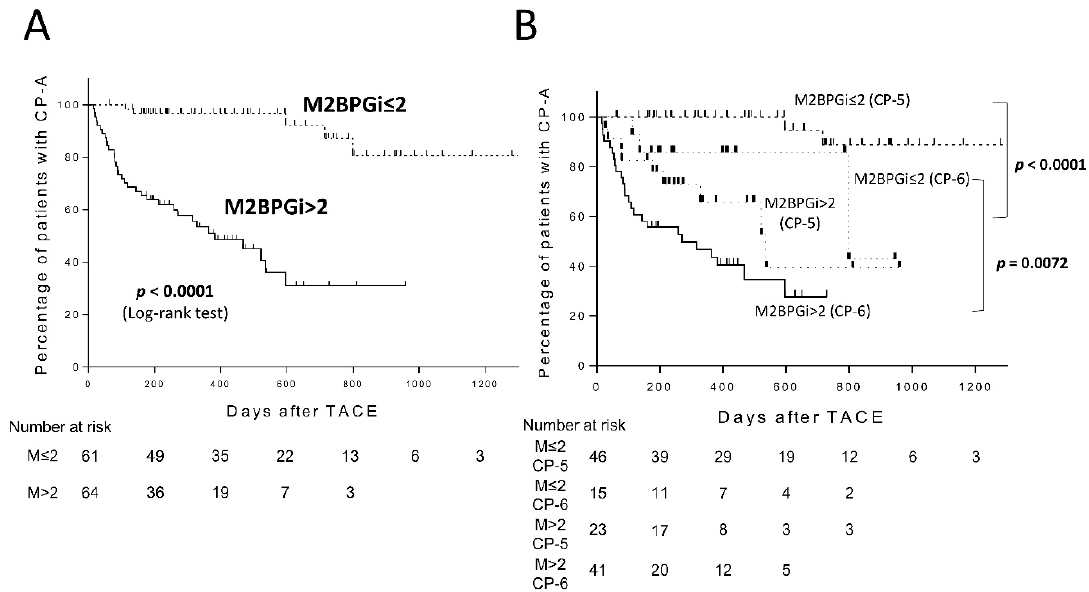
Figure 2. Child-Pugh grade deterioration from A to B after transarterial chemoembolization (TACE) in patients with Child-Pugh grade A (CP-A) according to Mac-2 binding protein glycosylation isomer (M2BPGi) levels ( A ) and according to M2BPGi levels and Child-Pugh score of 5 (CP-5) or 6 (CP-6) ( B ).